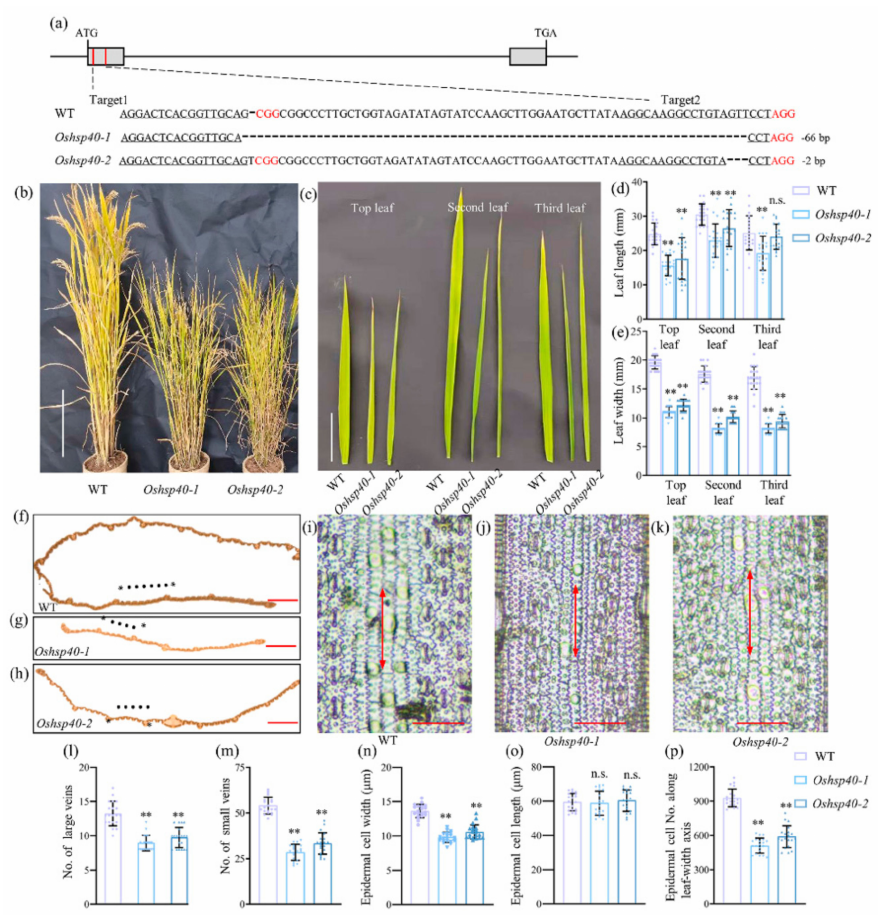
Figure 4. Function verification of the candidate gene OsHSP40 for LM7. ( a ) Oshsp40-1 and Oshsp40-2 mutants generated in wild-type (WT) Zhenggeng 1925 by CRISPR/Cas9 approach. A total of 66 and 2 bp nucleotides were deleted in Oshsp40-1 and Oshsp40-2 respectively. The two sgRNA:Cas9 target sites are labelled in red lines; gray rectangles indicate exons. ( b ) Representative image of mature plant of WT and Oshsp40 mutants. Scale bar is 20 cm. ( c ) Representative image of the top, second, and third leaf in WT and Oshsp40 mutants. Scale bar is 1 cm. The mean value of ( d ) leaf length and ( e ) leaf width. Cross section of ( f ) WT, ( g ) Oshsp40-1 , and ( h ) Oshsp40-2 leaves. Asterisks represent large veins and solid circles represent small veins. Scale bar is 1 mm. A clear show of epidermal cells of ( i ) WT, ( j ) Oshsp40-1 , and ( k ) Oshsp40-2 leaves. Scale bars = 50 µ m. The mean value of ( l ) large veins number, ( m ) small veins number, ( n ) epidermal cell width, ( o ) epidermal cell length, and ( p ) epidermal cell number along leaf-width axis. Significant differences compared with the WT were determined using Student’s t -test: ** p < 0.01. n.s. means not